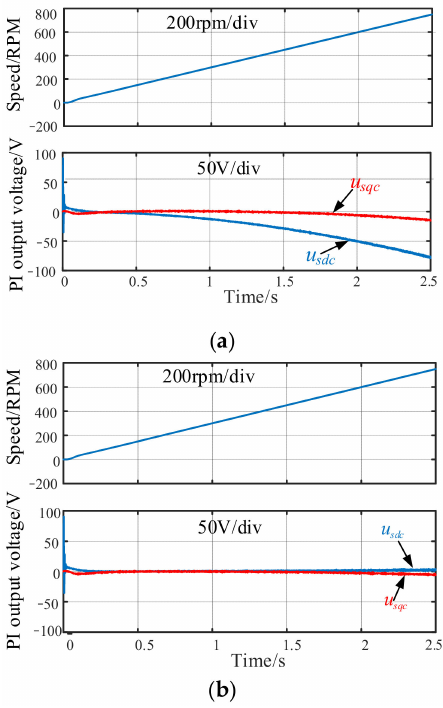
Figure 16. Simulation results of current controller outputs before and after delay compensation: ( a ) Before compensation; ( b ) After